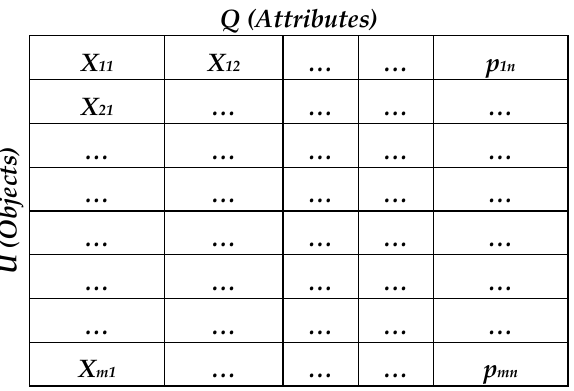
Figure 1. Example of the information table.